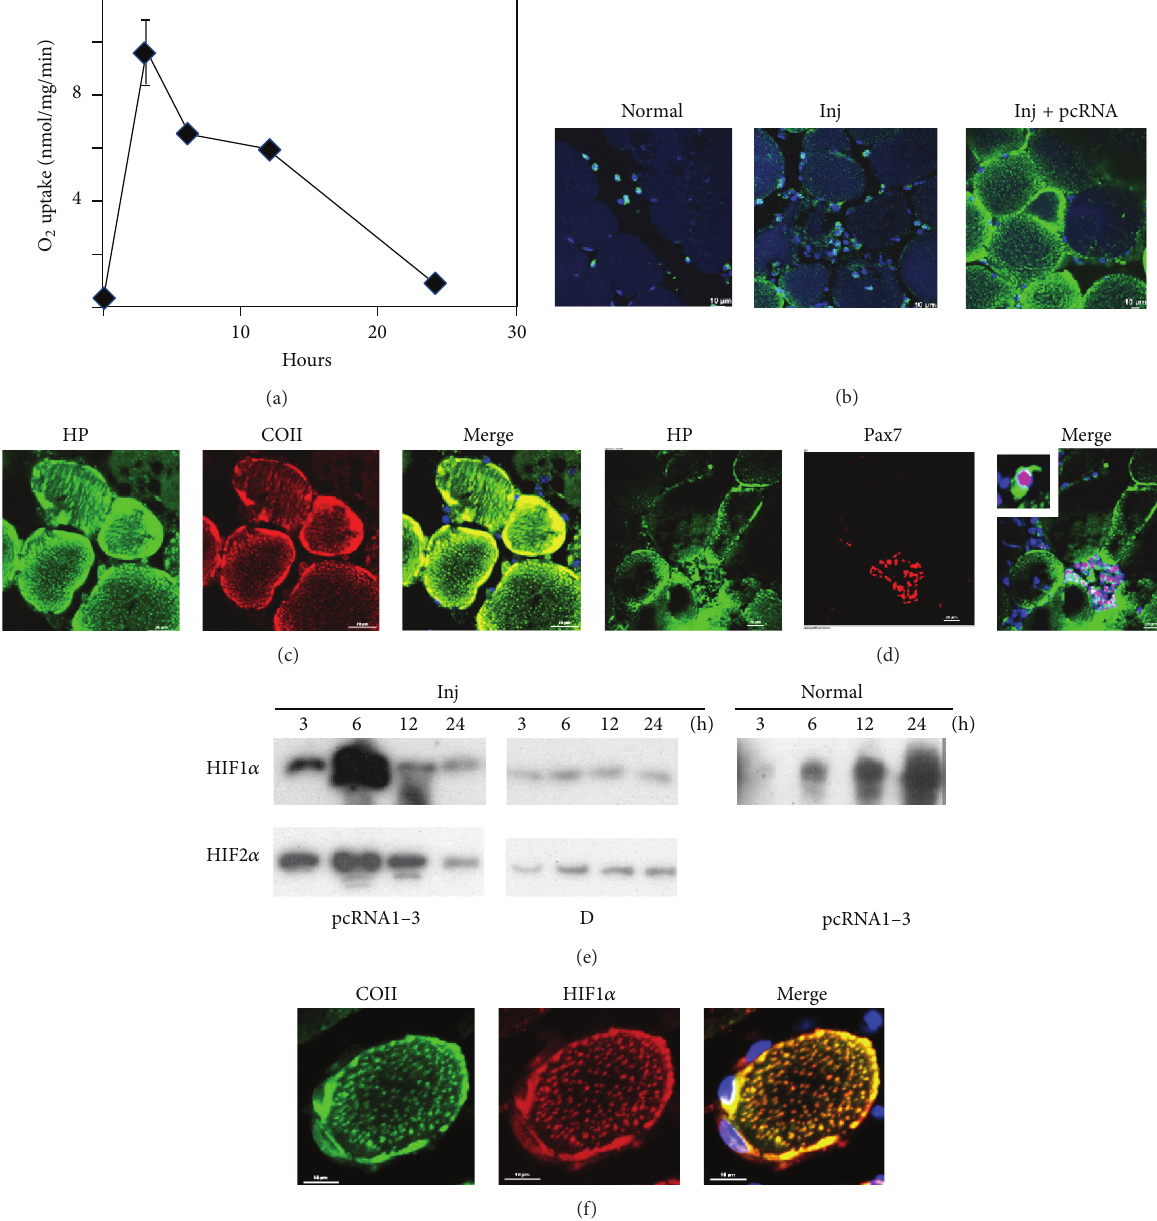
Figure 1: The hypoxic response at the injury site after mitochondrial restoration. (a) O 2 uptake rate (state 3 respiration) of mitochondria from 6 d injured muscle treated with the pcRNA1–3 combination for the indicated times. (b) Normal (left), injured (middle), or injured muscle treated with pcRNA1–3 for 4 h (right). Hypoxyprobe was injected at the injury site, and the tissue was fixed after 1h and stained with FITC- labeled antipimonidazole antibody. (c, d) Injured muscle treated with pcRNA1–3 was double stained for Hypoxyprobe (green) and COII (red, (c)) or Pax7 (red, (d)). (e) Western blots of injured (inj) or normal muscle treated with pcRNA1–3, or control D arm, for the indicated times, probed with anti-HIF1 𝛼 (upper row) or HIF2 𝛼 (lower row). (f) A higher magnification image of a single myofiber after pcRNA treatment for 3 h, showing colocalization of HIF1 𝛼 (red) with mitochondria expressing COII (green). Scale bars, 10 𝜇